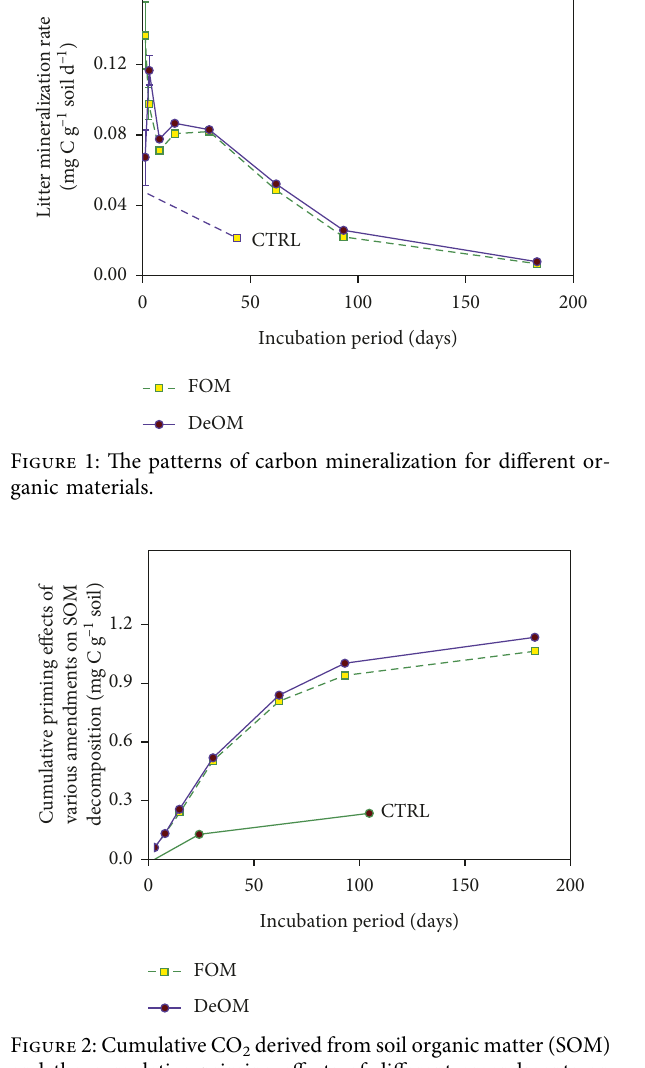
Figure 2: Cumulative CO 2 derived from soil organic matter (SOM) and the cumulative priming effects of different amendments on SOM decomposition with incubation time.